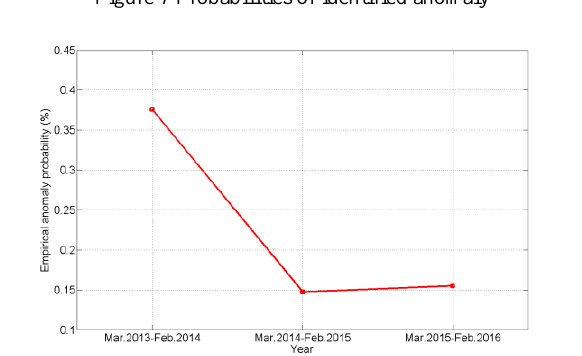
Figure 7 Probabilities of identified anomaly